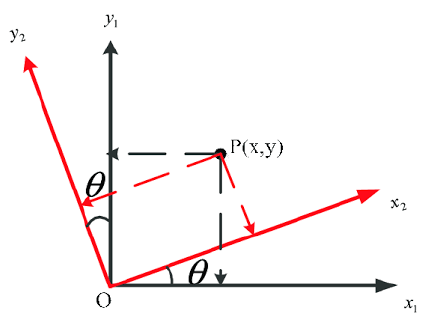
Figure 2. The rotation of two-dimensional rectangular coordinate system through angle θ .